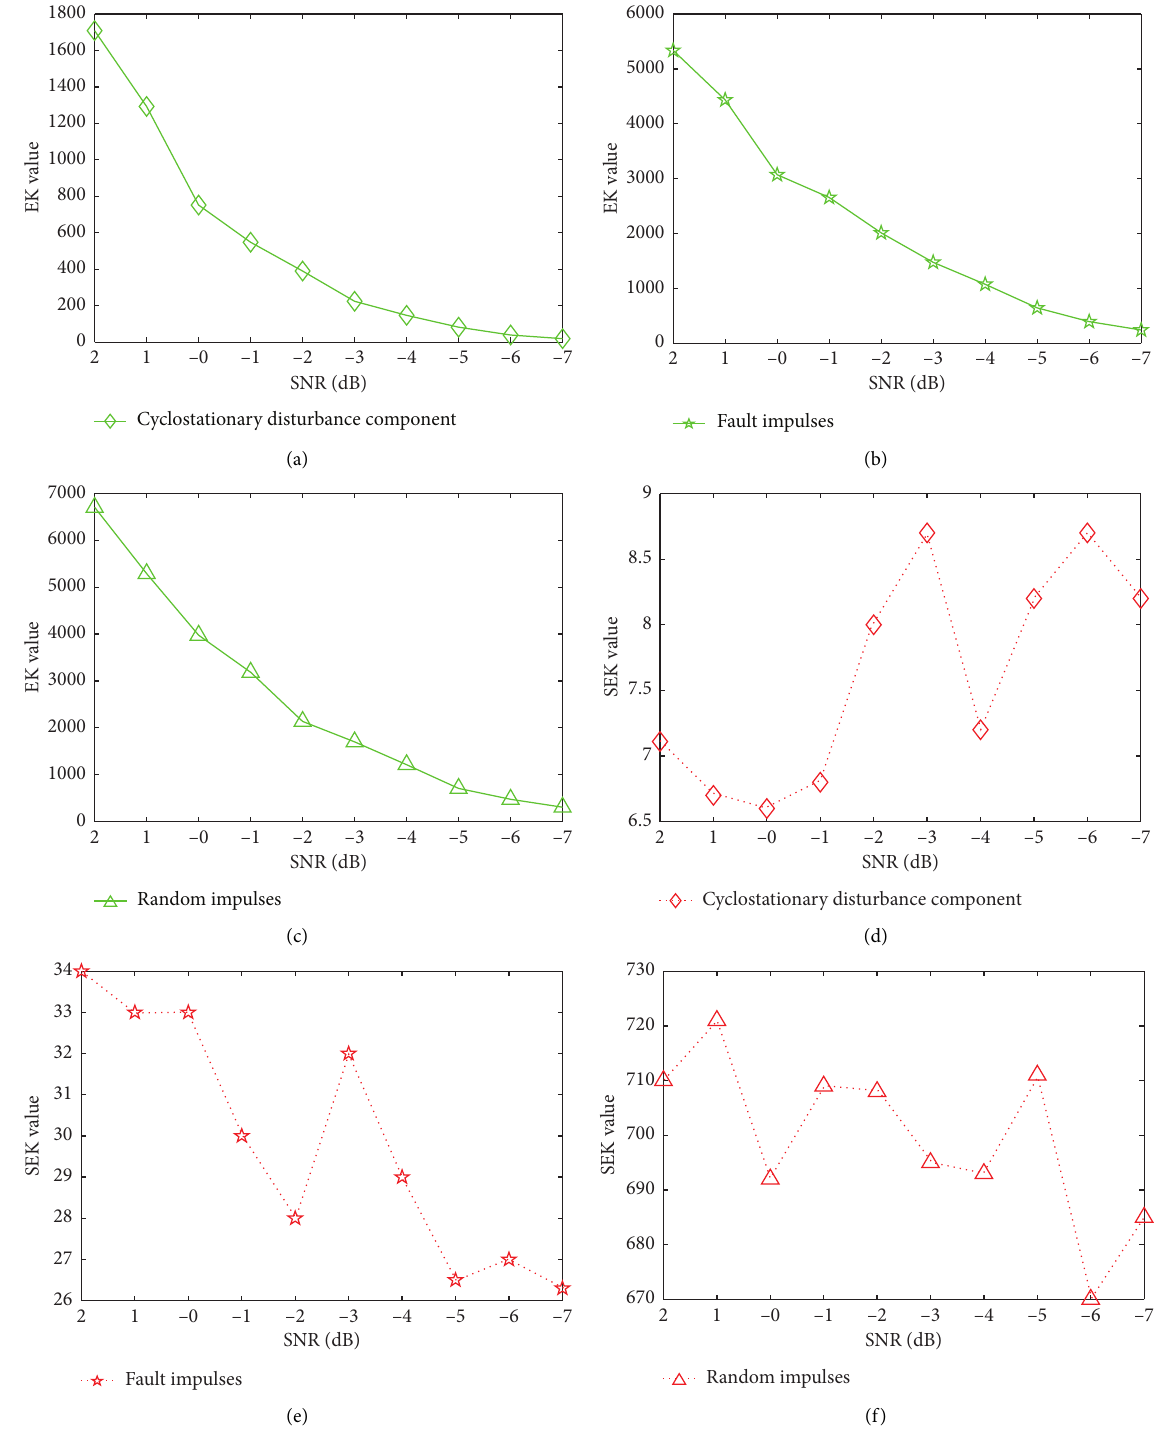
Figure 1: Variation curves of EK and SEK values of different components in the bearing signal under different SNRs: (a, d) the cyclic stationary interference part, (b, e) fault impulses part, and (c, f) the random impulses